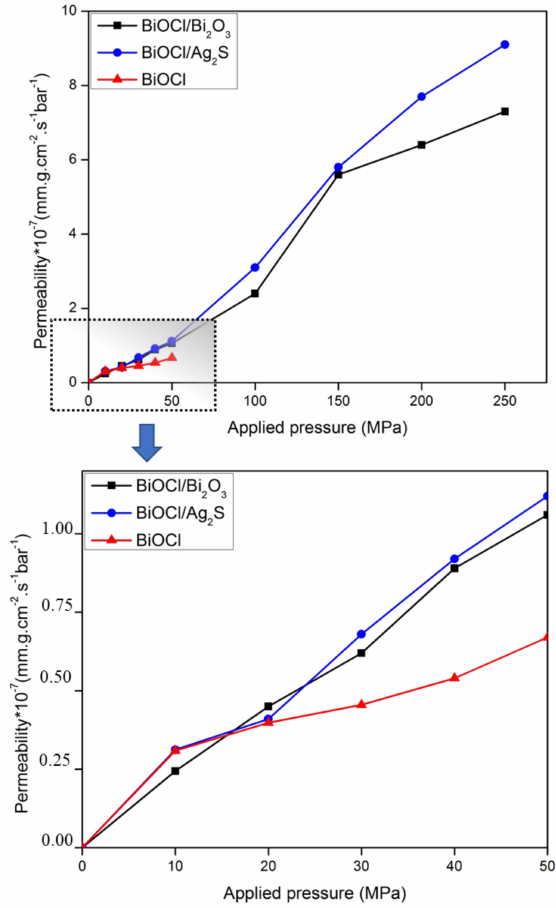
Figure 9. Water permeability rate of membranes under the suggested external pressure between 50 and 250